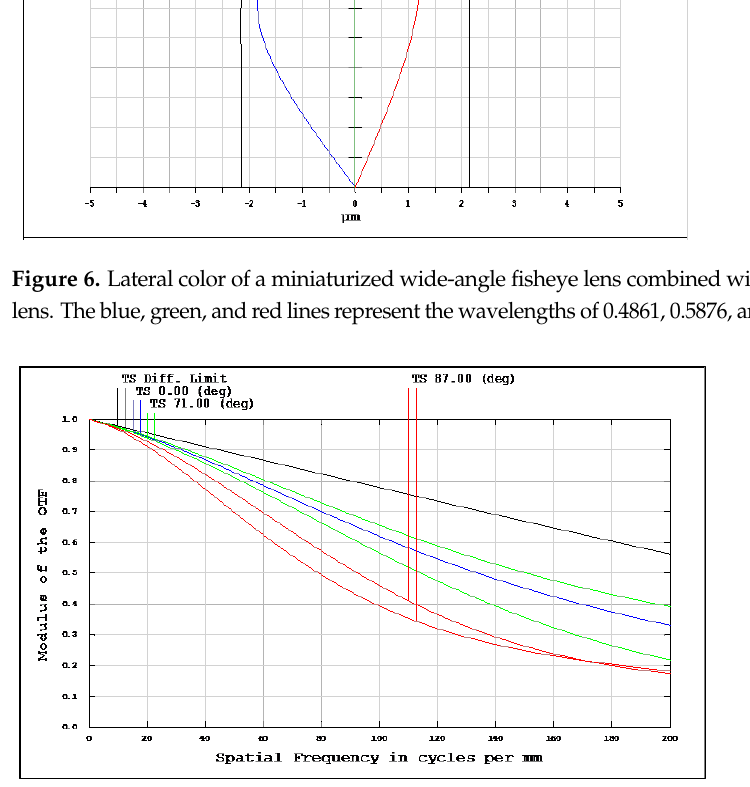
Figure 7. Modulation-transfer-function (MTF) curves of a miniaturized wide-angle fisheye lens combined with an OKP4HT aspherical lens. The blue, green, and red lines represent the tangential and sagittal (T = tangential; S = sagittal) directions for the 0°, 71°, and 87° cases, respectively.